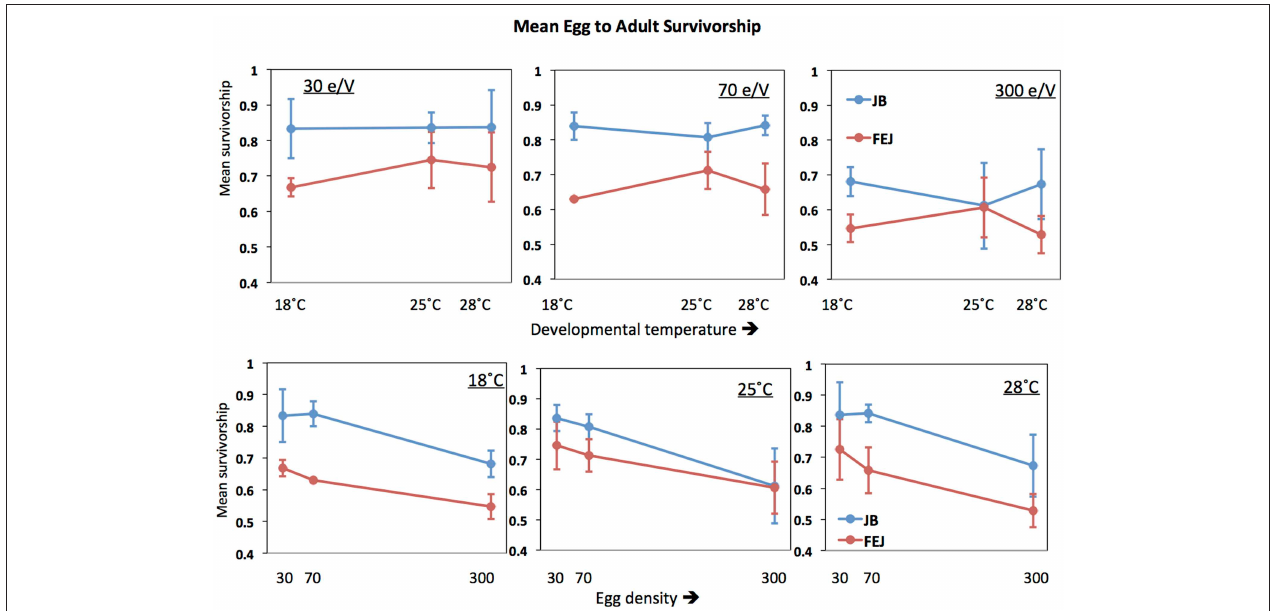
FIGURE 4 | Mean pre-adult survivorship of FEJ and JB populations. The upper panel shows mean trait value plotted across temperature for each treatment density (e/V = eggs per vial). The lower panel shows mean trait value plotted across egg density for each treatment temperature. The error bars show 95% confidence intervals calculated from the variation among replicate populations in each combination of selection regime, temperature, and density.